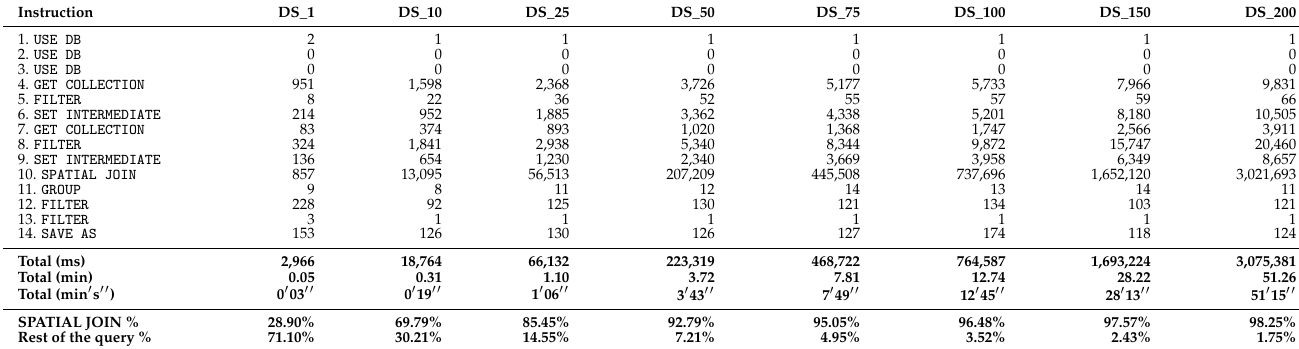
Table 5. Execution times (in ms) for data sets DS_1 , DS_10 , DS_25 , DS_50 , DS_75 , DS_100 , DS_150 and DS_200 .